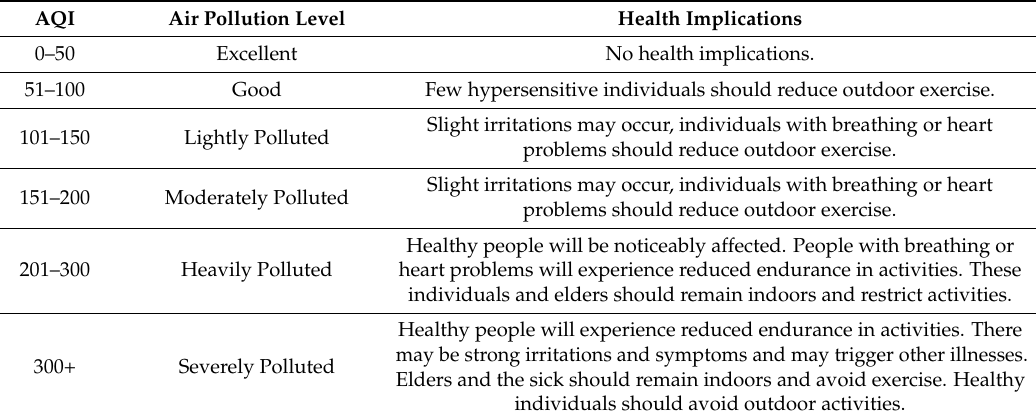
Table 1. AQI category and health implications according to ambient air quality index (AQI) technical regulations (trial) (HJ